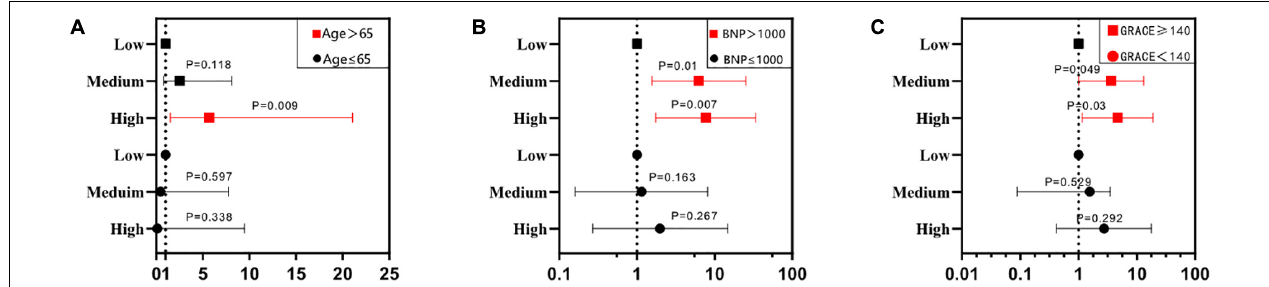
FIGURE 4 | Subgroup analysis of different patients. Panels (A–C) represent the subgroups across different ages, NT-pro BNP levels, and GRACE scores. The red line denotes a statistically significant subgroup.